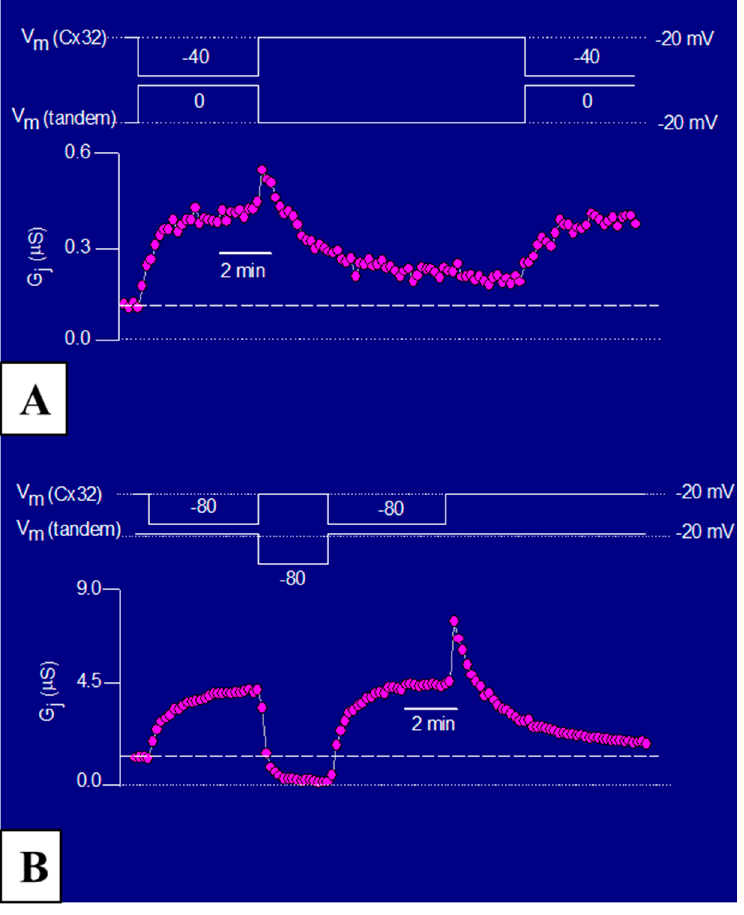
Figure 8. Response of Gj to steady-state Vj in tandem-32 channels ( A , B ). In oocytes initially clamped at Vm = 20 mV (Vj = 0), a 40–60 mV Vj step (tandem side positive) exponentially increases Gj in tandem-32 channels ( A , B ). Upon return to Vj = 0 mV from Vj = 40 mV ( A ), Gj decreases exponentially to near control values. With Vj reversal to 60 mV (tandem side negative), Gj decreases exponentially below control values ( B ), indicating that Vj negative at the tandem side actively closes channels. Upon return to Vj = 0 from Vj = 40 ( A ) or 60 ( B ) mV (tandem side positive), Gj increases abruptly before dropping ( A , B ), because the fast Vj-gates of the Cx32 side reopen (Cx32 is a negative gater). Of course, this is not observed with Vj polarity reversal ( B ) because while the fast Vj-gates open at Cx32wt side (positive Vj side) they close at the tandem side (negative Vj side). From [77].